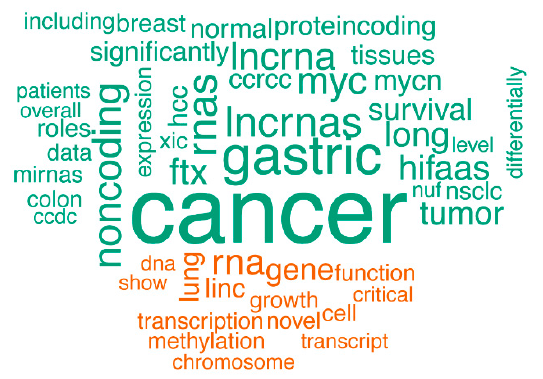
Figure 3. A comparison word cloud shows strong enrichment of the word “cancer” in abstracts of publications associated with the lncRNAs affected by SCNAs. The size of each word corresponds to the deviation of its frequency in abstracts associated with the lncRNAs affected by SCNAs from the average occurrence frequency. Green words are more prevalent in abstracts on lncRNAs affected by SCNAs, while orange words are more prevalent in the abstracts on lncRNAs unaffected by